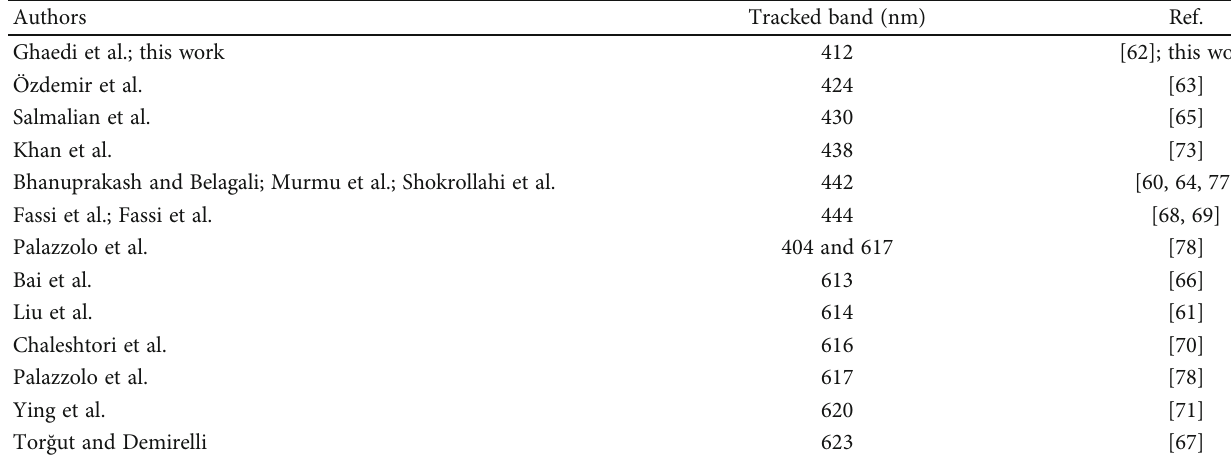
Table 4: Literature reported BCG reference